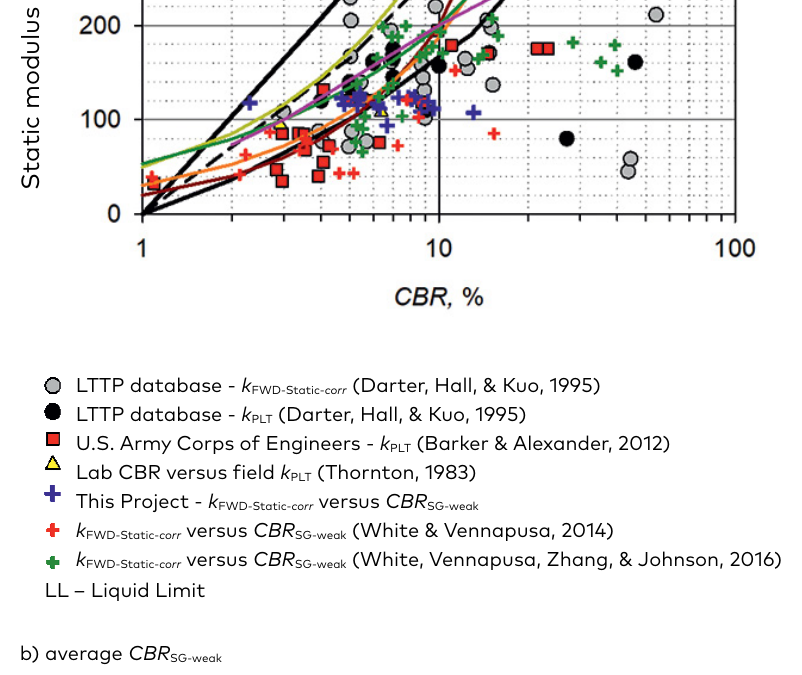
Figure 8. Average k FWD–Static– corr versus average CBR values compared to relationships published in the